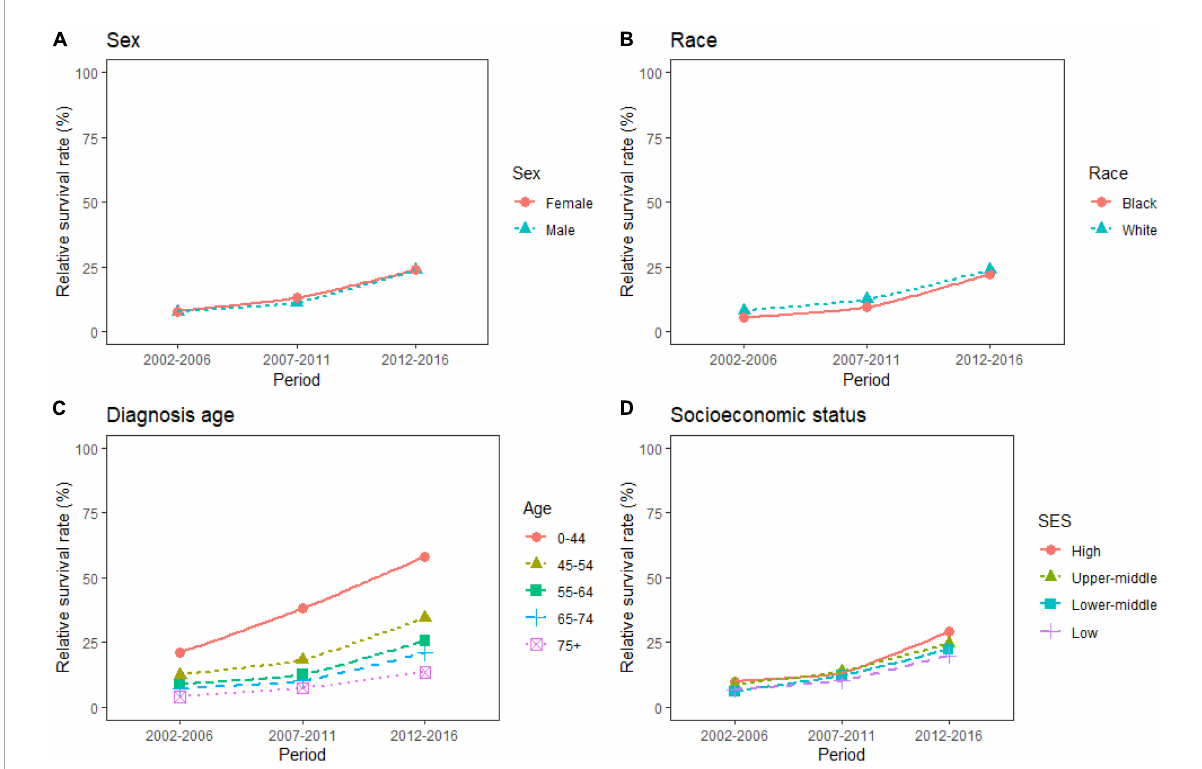
FIGURE1 (A–D) Five-year relative survival rates according to sex (female and male), race (black and white), diagnosis age (0–44, 45–54, 55–64, 65–74, and 75+), and socioeconomic status (high income, upper-middle income, lower-middle income, and low income) for patients with pancreatic cancer (PC) from 2002 to